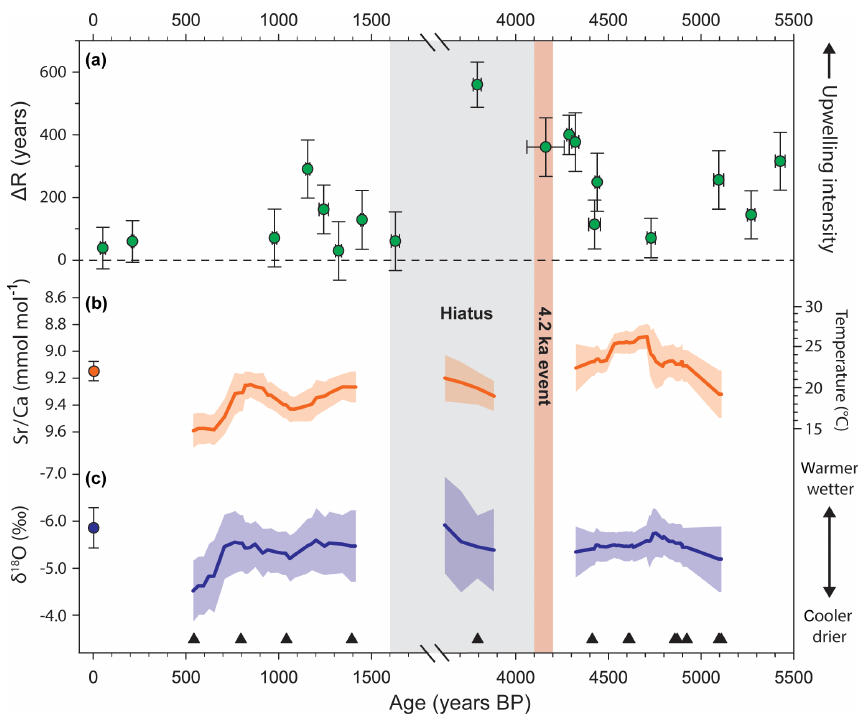
Figure 2. Coral-based reconstructions of oceanographic and climatic variability in Pacific Panama from 5500BP to present (after Toth et al., 2015a, b). Plot (a) provides a reconstruction of upwelling intensity in the Gulf of Panama based on the location-specific radiocarbon-reservoir age offset, (cid:49)R (Toth et al., 2015b). Plots (b) and (c) provide reconstructions of temperature and salinity variability for Pacific Panama based on 200-year running means ( ± 95%CIs, confidence intervals) of Sr / Ca and δ 18 O, respectively, of corals sampled from a core collected from the reef at Contadora Island in the Gulf of Panama. The individual data points used to generate the curves can be found in Toth (2013) and Toth et al. (2015a). Modern values are means ( ± 95% CIs) measured from living corals collected from the same reef in 2011 (described in Toth et al., 2015a). The timing of the 4.2ka event and the hiatus in the development of reefs in Pacific Panama are indicated by the red and gray bars,